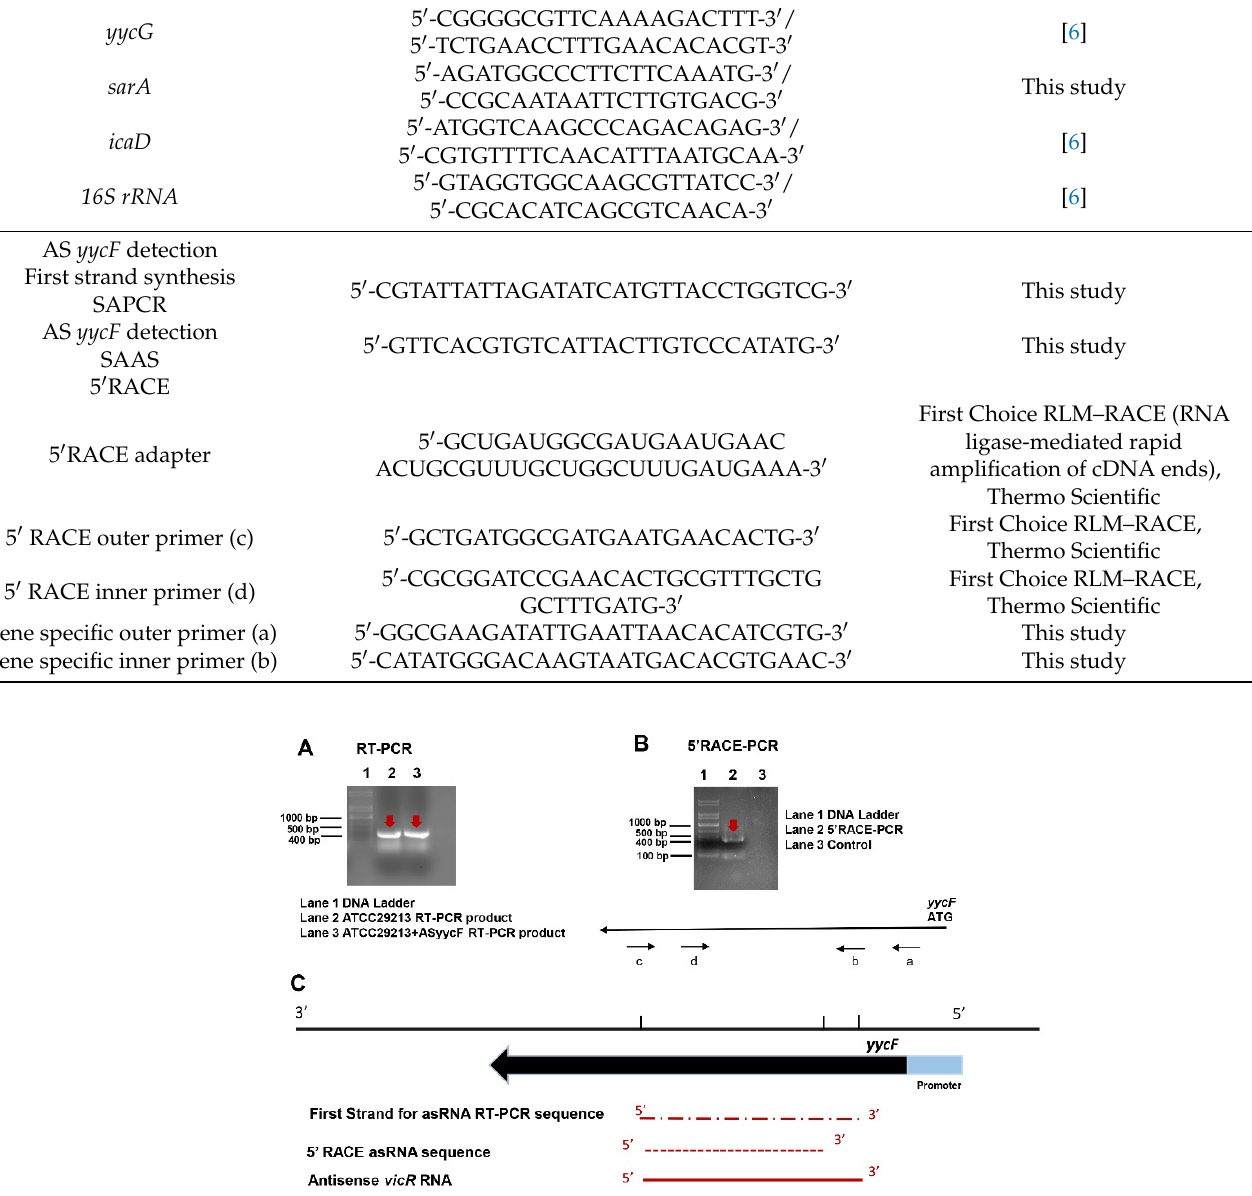
Figure 1. Detection of antisense yycF RNA. ( A ) Total RNA samples were isolated from S. aureus to detect AS yycF RNA transcription by first cDNA strand synthesis and RT-PCR (red arrows). ( B ) Detection of the 5 (cid:48) terminus of the AS yycF transcription by 5 (cid:48) RACE (red arrows): (a) gene-specific outer primer; (b) gene-specific inner primer; (c) and (d) are 5 (cid:48) RACE outer and inner primers, respectively. ( C ) Schematic of AS yycF showing that transcription starts within the 5 (cid:48) terminus in the yycF open reading frame (ORF). The full length for AS yycF RNA is approximately 400 bp.